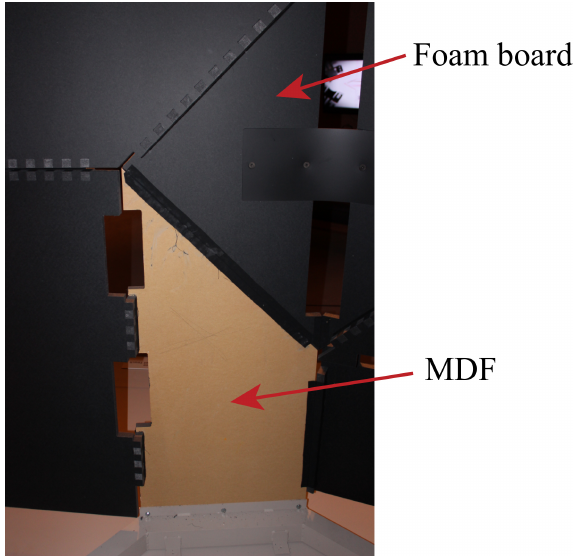
Figure 6. A foldable circuit board with one panel constructed from metal. The thickness of the panel is approximately 0.063